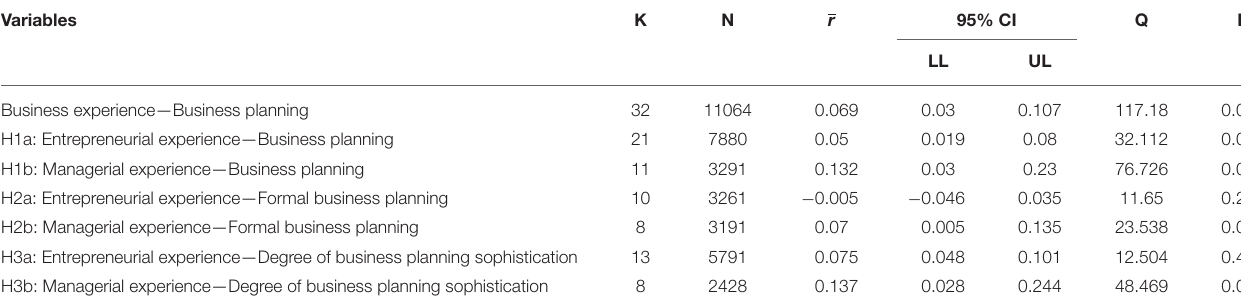
TABLE 2 | Meta-analysis of relationships between business plan and experience.